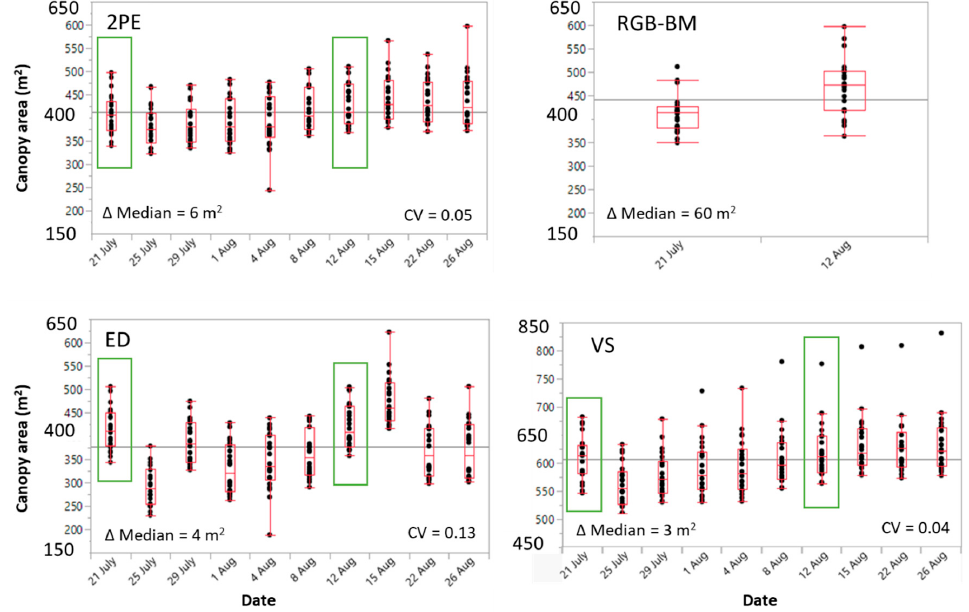
Figure 3. Canopy area (m 2 ) per management cell (MC) (black dots) and box plot (red) per day of image acquisition (21 July–26 August 2019). The black horizontal line is the grand mean. The green boxes indicate data from 21 July and 12 August of the 2-pixel erosion (2PE), edge detection (ED), and vegetation segmentation (VS) methods. The RGM binary masking (RGB-BM) method was performed only on these dates. Note: the Y-axis range of the VS method is specifically different from the other methods.